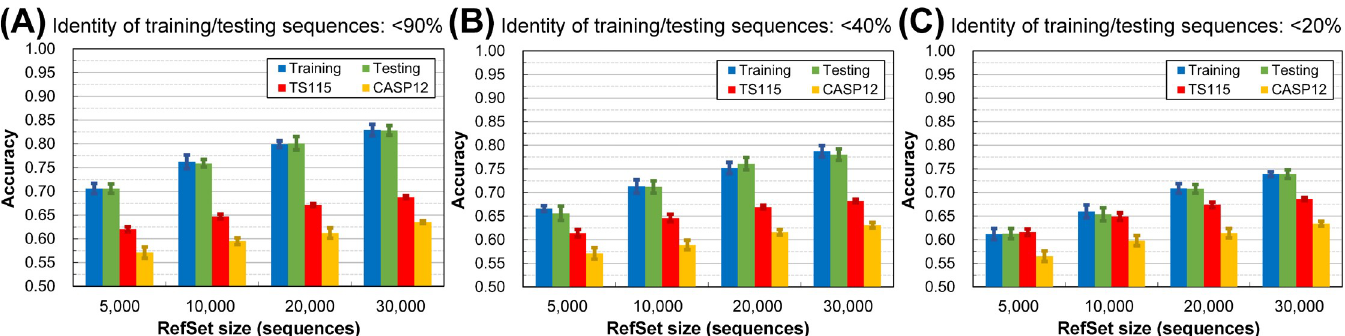
Fig 14. The influence of reference dataset size on the accuracy of SSP. (A) SSP accuracies of different reference dataset sizes under 90% identity of query sequences. (B) SSP accuracies of different reference dataset sizes under 40% identity of query sequences. (C) SSP accuracies of different reference dataset sizes under 20% identity of query sequences. The accuracy in training, testing, and independent tests all increased as the reference dataset expanded. Regardless of the homology of training/testing query sequences, the increasing trends of independent tests were nearly the same; meanwhile, the extent of accuracy increase in training and testing was greatly affected by the identity of query sequences. The gap of accuracy between training/testing and independent tests stands for over-fitting predictions. The overfitting in SSP will increase as the reference dataset size grows, especially when the homology of training/testing sequences is high.